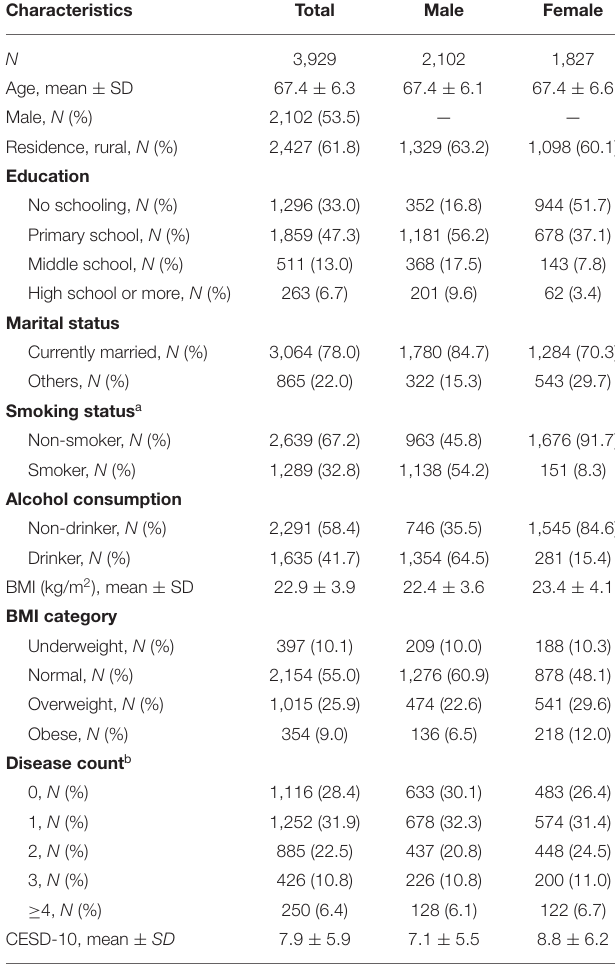
TABLE 2 | Summary characteristics of the study participants in